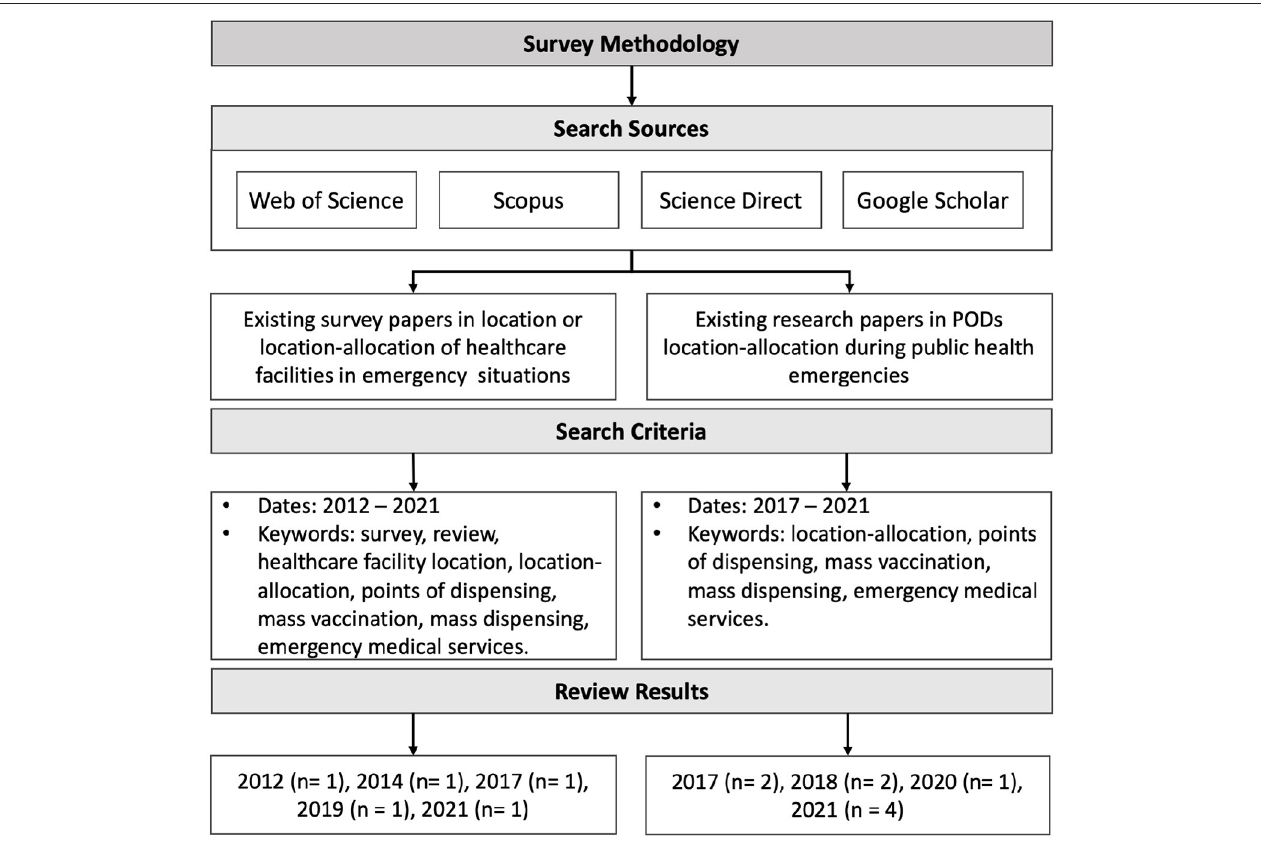
FIGURE 2 | Survey methodology. n refers to number of retrieved papers.